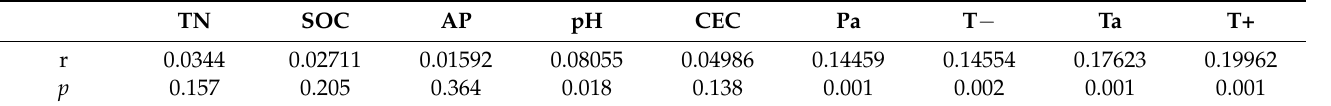
Table 6. Correlations between fungal community composition and climate factors/soil properties as-sessed by Mantel